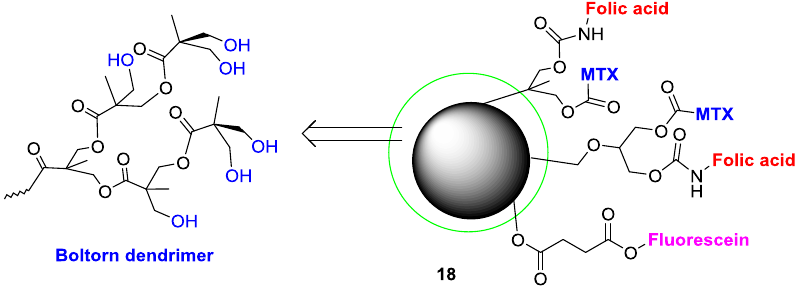
Figure 7. The synthesis of the folic acid-based targeted drug delivery system